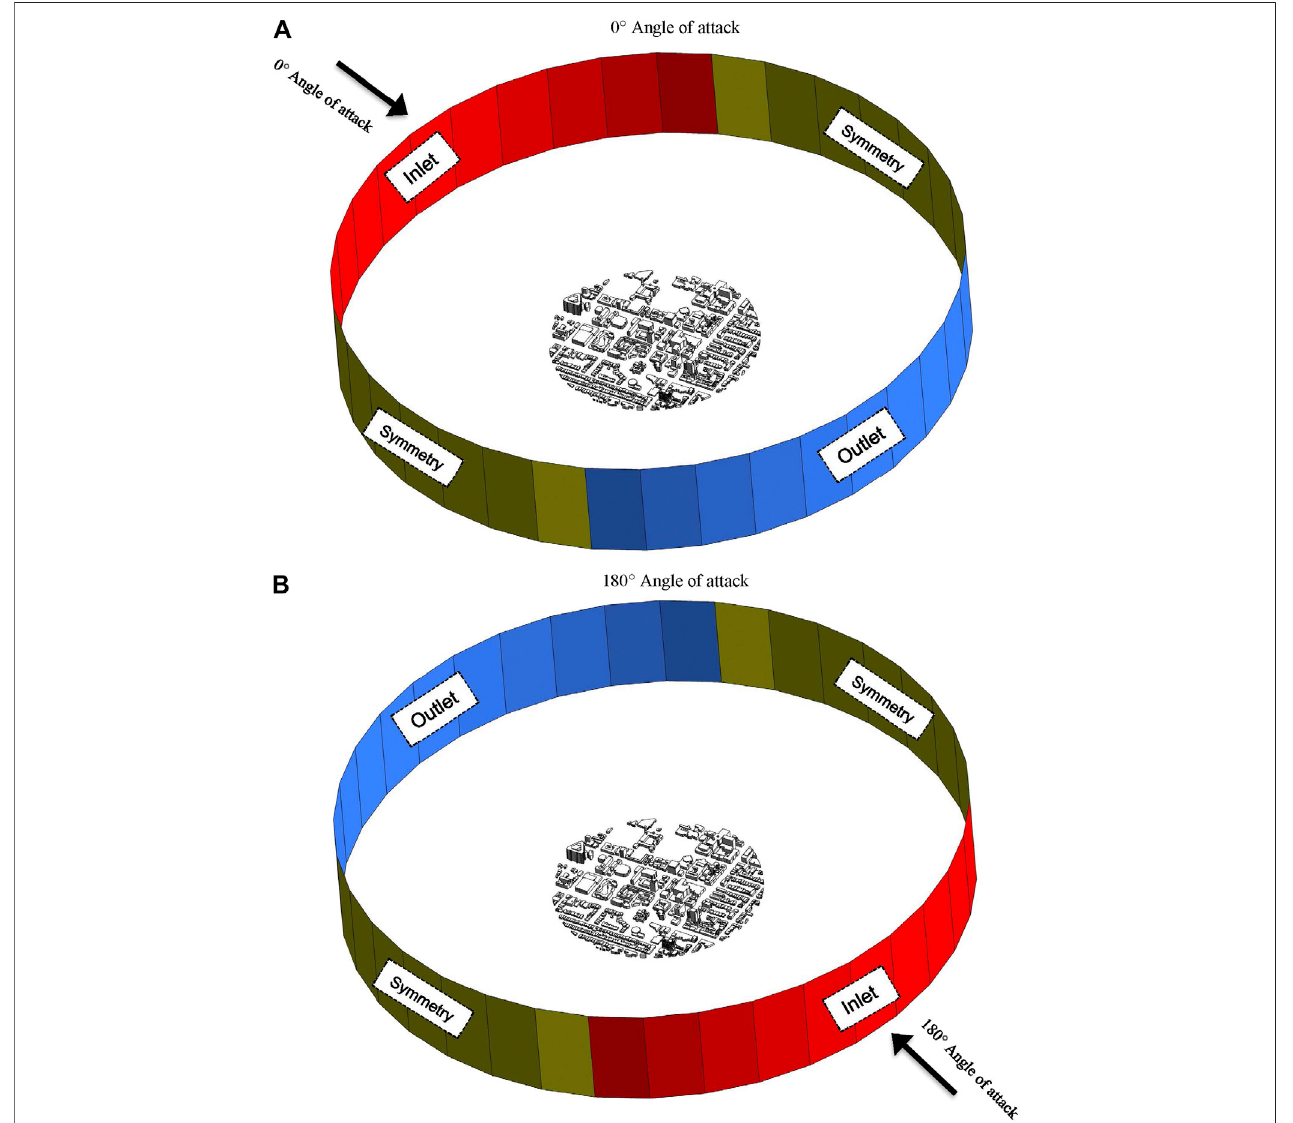
gradients. G b represents the generation of turbulent kinetic energy due to buoyancy. Y M represents the contribution of fl uctuating dilation in compressive turbulence to the overall dissipation rate. σ k and σ ε are Prandtl numbers according to k and ε , S k and S ε are source terms as de fi ned by the user. C 1 ε and C 2 are constants. The computational domain with boundary conditions is shown in Figure 3 . The lower surface of the computational domain adopted a non-slip wall boundary condition and the distance between the inlet and the study area has been chosen (Aboshosha et al. (2015); Elshaer et al. (2016)) to ensure the stability of the developed in fl ow boundary condition. This distance has been previously identi fi ed by